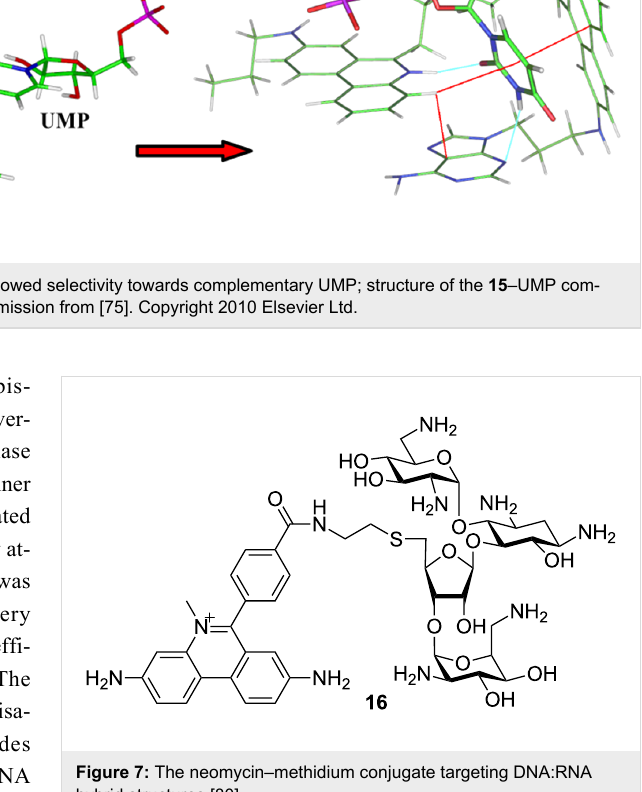
RNA-intercalated phenanthridinium fluorophore (Figure 8,